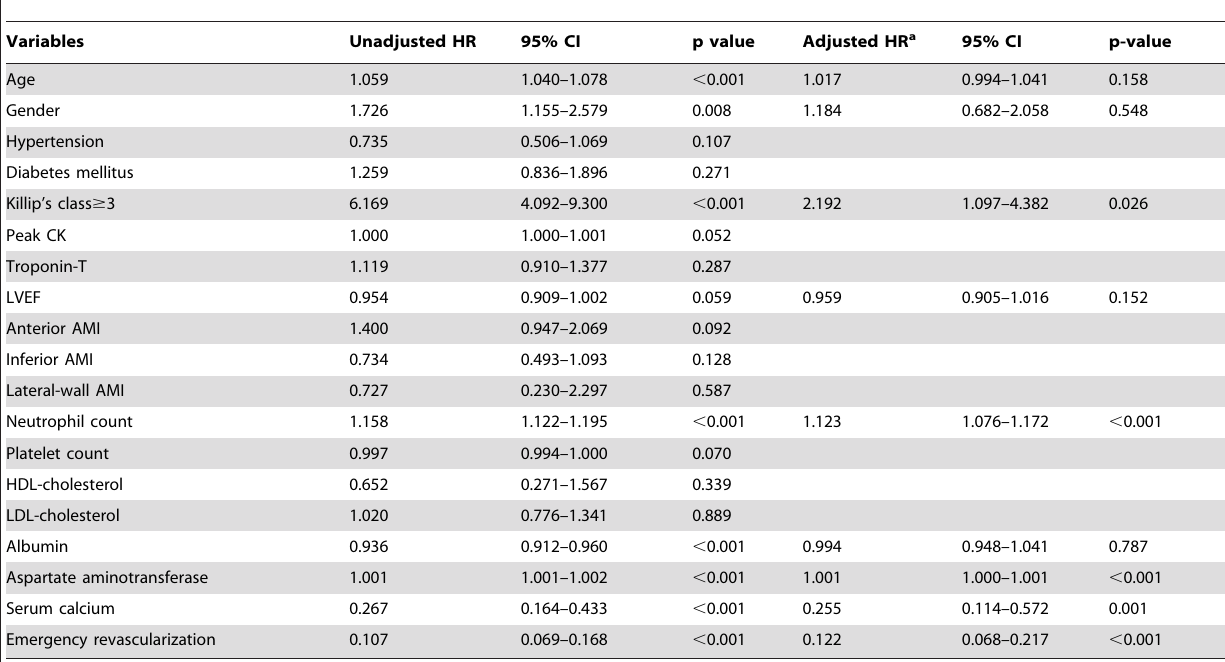
Table 3. Univariate and multivariable Cox regression analyses of factors associated in-hospital